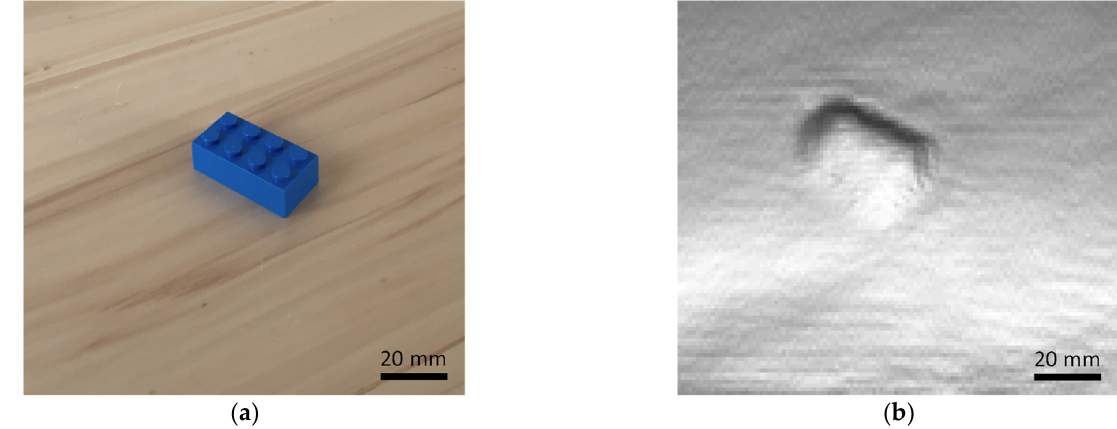
Figure 3. ( a ) Screenshot of the camera preview of a Lego brick on an iPad Pro (2020); ( b ) Screenshot of the scanning preview via LiDAR in the same scenario using the Heges App on an iPad Pro (2020).